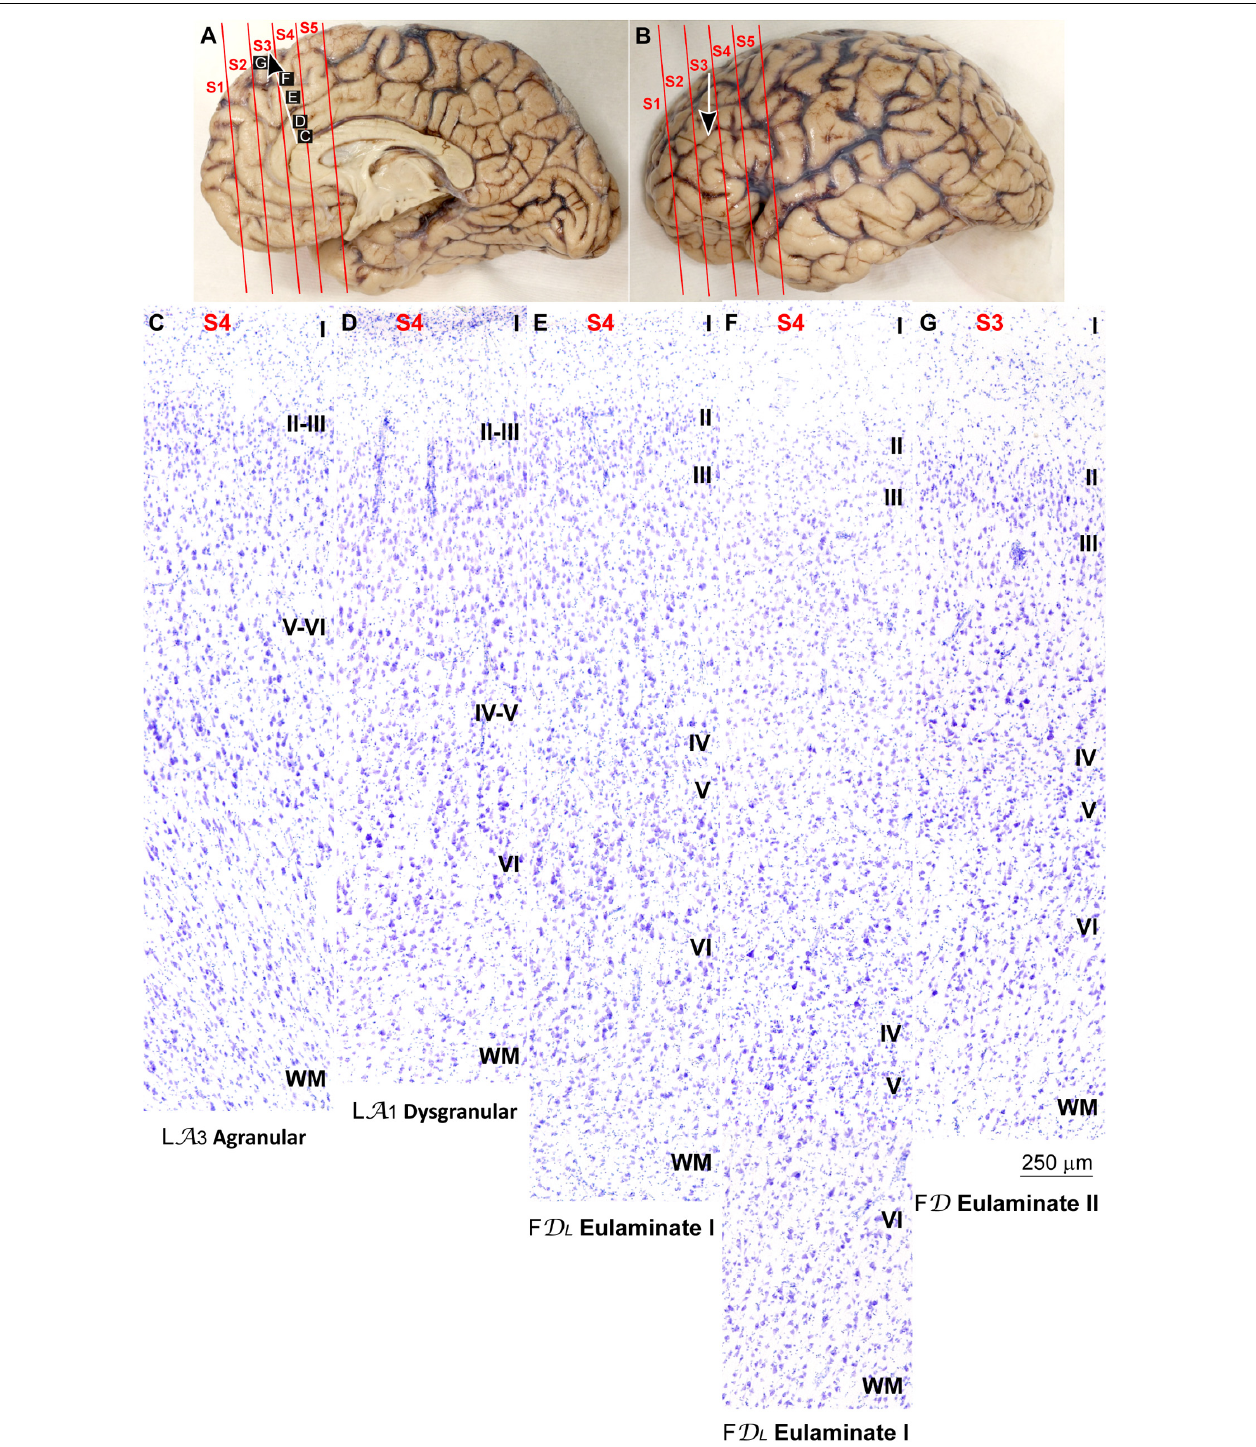
FIGURE 4 | Systematic and gradual variation of laminar structure across areas of the parahippocampal trend in the human prefrontal cortex: Anterior cingulate and medial prefrontal areas. (A,B) , Medial (A) and lateral (B) views of the left hemisphere from the brain (case HCD): red lines show the planes of separation of coronal slabs; black and white arrows indicate laminar differentiation along the parahippocampal trend. (C–G) , Micrographs of the anterior cingulate and medial prefrontal cortex in Nissl stained sections at the levels indicated in (A) ; the areas according to the Atlas of von Economo and Koskinas (1925/2008) and the cortical type are indicated below each micrograph; see the text for description of laminar features. S1, S2, S3, S4, S5, indicate coronal slabs from anterior to posterior; WM, white matter. Roman numerals indicate cortical layers. Calibration bar in (G) applies to (C–G) .